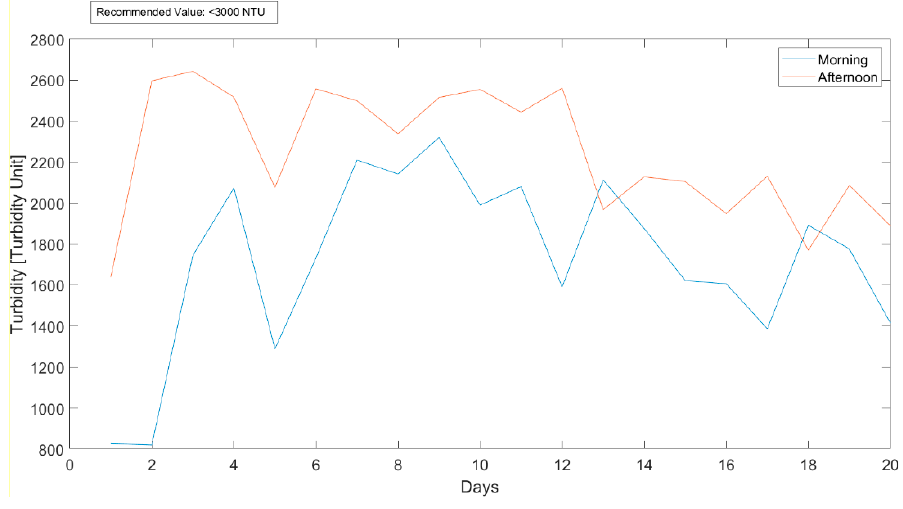
Figure 10. Turbidity variation. 276